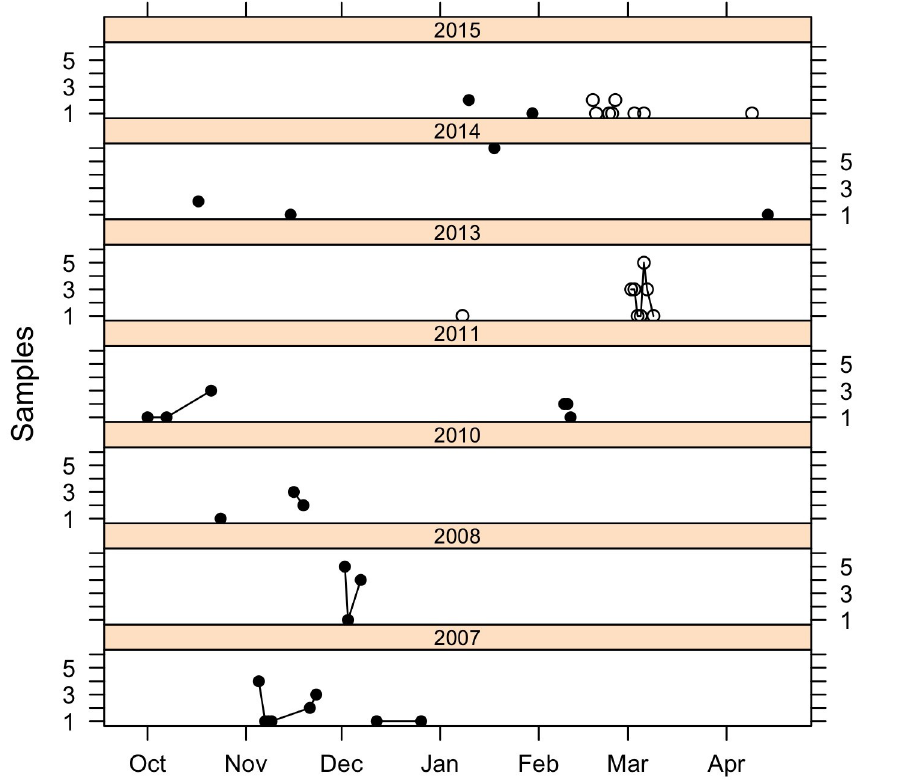
Fig 2. Months and years of Southern Resident killer whale fecal sample collections. Y-axis indicates number of samples collected per day that were included in the analysis. Open and filled symbols indicate outer coast and Salish Sea samples, respectively. Fecal samples that were pooled prior to sequencing are connected by